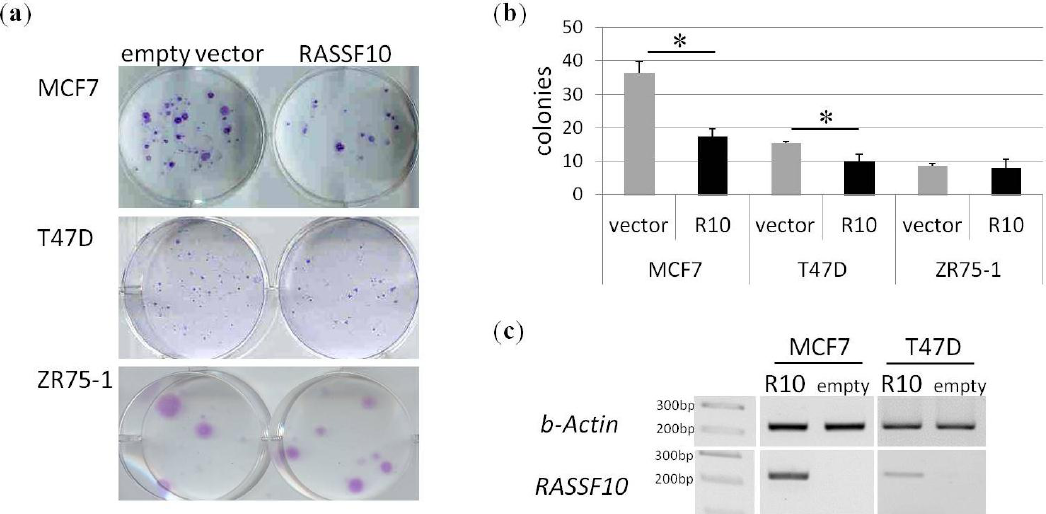
Figure 4. RASSF10 inhibits growth of breast cancer cell lines. ( a ) Colony formation analyses were performed in breast cancer cell lines MCF7, T47D and ZR75-1 after empty vector and RASSF10 overexpression. Cells were selected for three weeks using G418 and were Giemsa stained for visualization; ( b ) Quantification of colony formation in breast cancer cell lines MCF7 ( p < 0.005) and T47D ( p < 0.05) shows significant inhibition of colony growth under RASSF10. Statistically significant (asterisks) by paired T-Test, two tailed; ( c ) Overexpression verification of RASSF10 in MCF7 and T47D cell lines by RT-PCR.